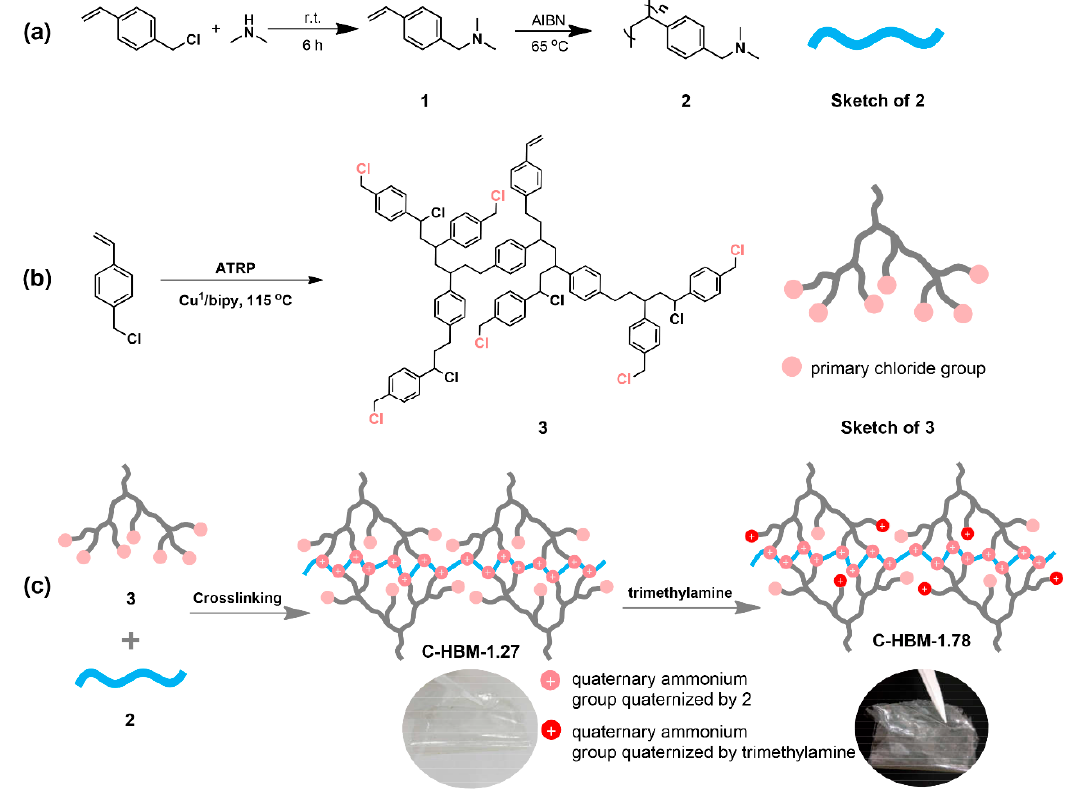
Scheme 1. Schematic synthesis of the quaternization reagent poly( N , N -Dimethylbenzylamine), the hyperbranched oligomer poly-4-vinylbenzyl chloride (HB-PVBC) and the crosslinked, hyperbranched membrane C-HBM-1.78 (ion exchange capacity (IEC) = 1.78 g − 1 ). ( a ) Synthesis of the monomer 1 ( N , N -Dimethylbenzylamine) through the amination of 4-vinylbenzyl chloride with dimethyl amine, and polyamine 2 (poly( N , N -Dimethylbenzylamine )) via radical polymerization; ( b ) synthesis of the hyperbranched oligomer HB-PVBC via atom transfer radical polymerization (ATRP) technique; and ( c ) the quaternization of HB-PVBC with poly( N , N -Dimethylbenzylamine) to yield densely functionalized ionomer C-HBM-1.27; further quaternization of C-HBM-1.27 with trimethylamine leads to membrane C-HBM-1.78 with a higher IEC value. AIBN, 2,2’- azodiisobutyronitrile.